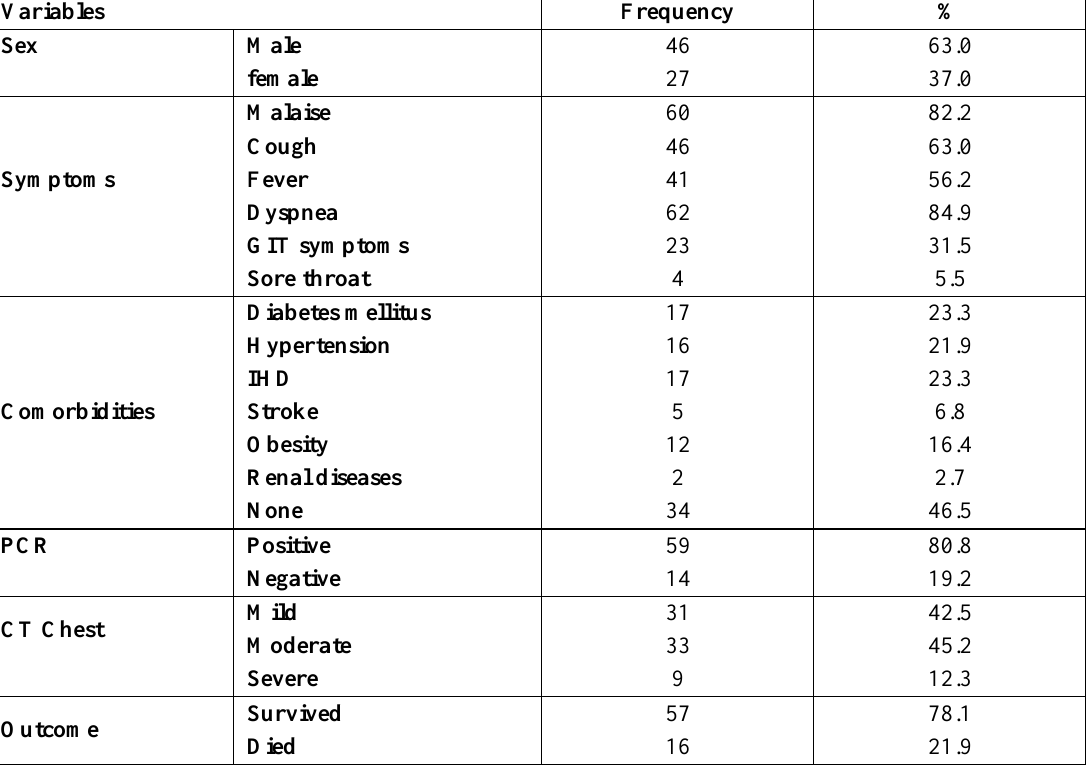
Table 1. Demographic features, symptoms, PCR and CT findings